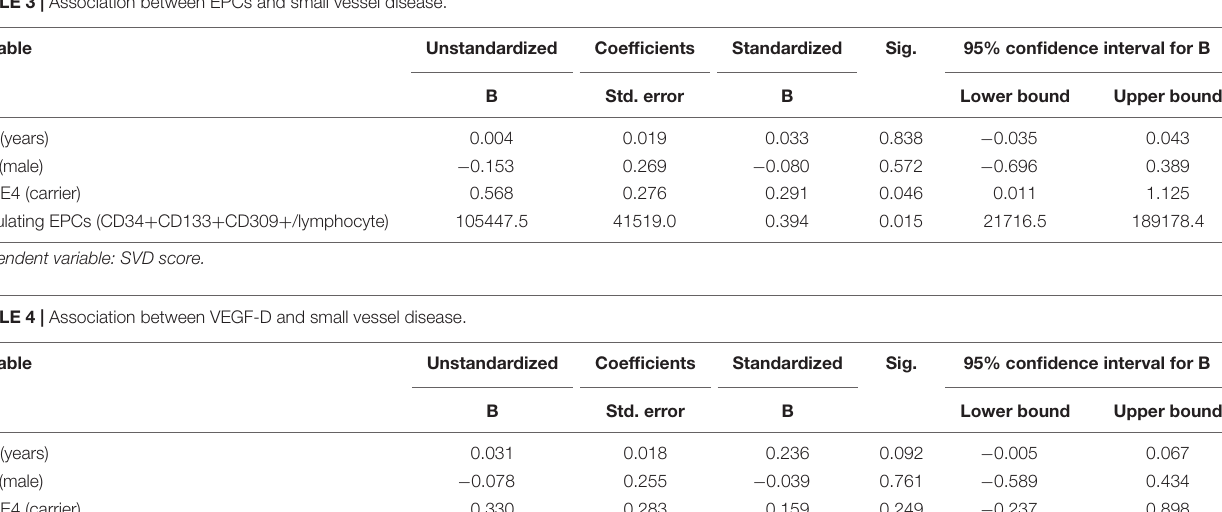
TABLE 3 | Association between EPCs and small vessel disease.